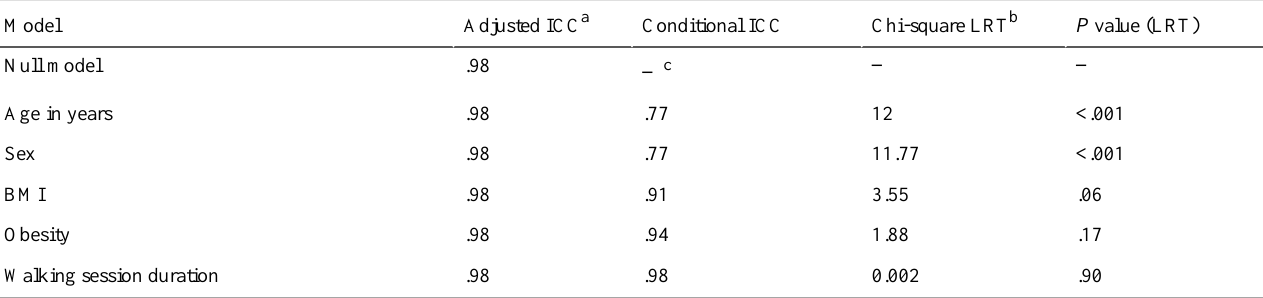
Table 2. Generalized linear mixed-model intraclass correlation coefficients (ICCs) have been estimated, providing a random effect term (random intercept) for individual measurements (gold standard and device). The adjusted ICC considers only the random effects, while the conditional ICC also takes the fixed-effect variances into account when evaluating how much the covariate variable explains the portion of the variation in the grouping structure (random intercept). The P value and chi-square test statistics are reported for the likelihood ratio test comparing the goodness of fit of the separate covariate-adjusted models with the intercept-only model (null